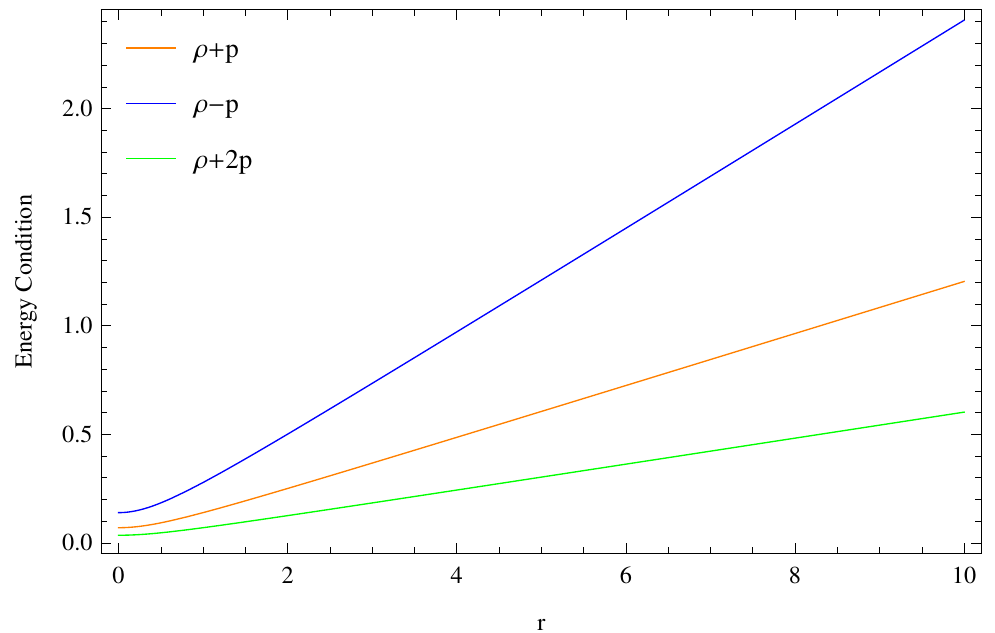
Figure 10. The energy conditions are plotted against the radial parameter r , for quintessence matter ( ω = − 1/3), and for the values of constants C 1 = 0.01, C 2 = 0.5, C 3 = 2. Case (ii) : Let Λ (cid:54) = 0, ω = −